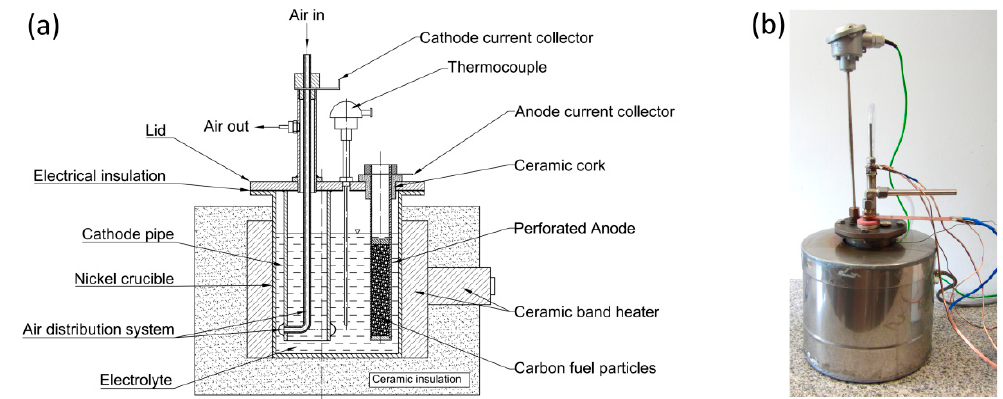
Figure 5. Design scheme ( a ) and photograph ( b ) of experimental Model III of MH-DCFC, made of nickel and high-nickel alloys. Table 4. Composition of nickel alloys used in the construction of Model III MH-DCFC (wt.%). Material